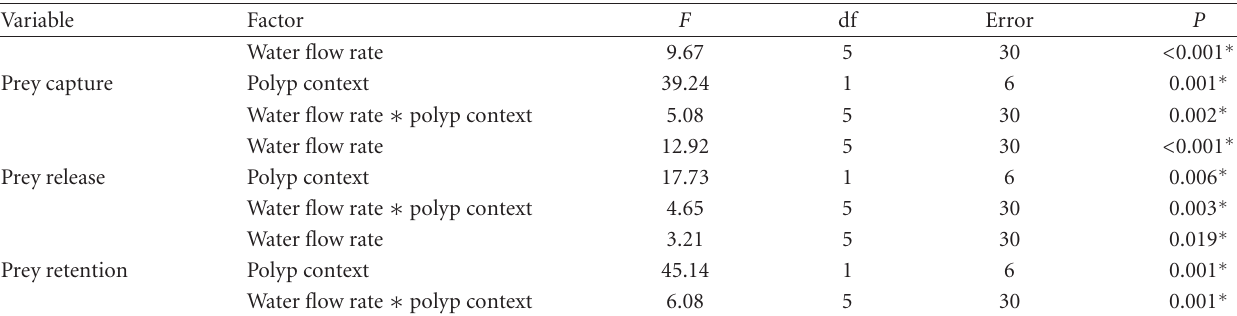
Table 1: Two-way mixed factorial ANOVA, showing main and interactive e ff ects of water flow rate and polyp context on prey capture, release, and retention by G. fascicularis polyps ( n =